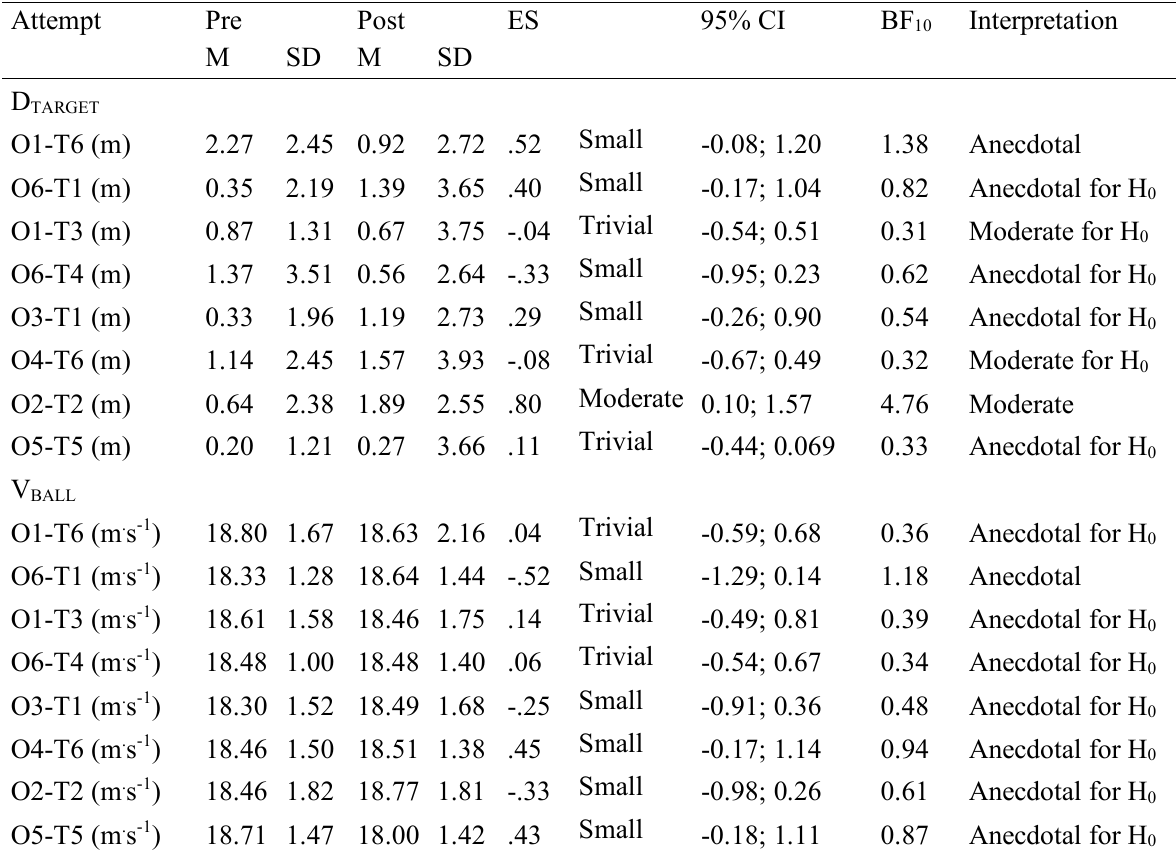
Table 2. Mean and standard deviation (standardized ES with a 95% confidence interval) for shooting performance variables according to attempts of same origin and target (n =